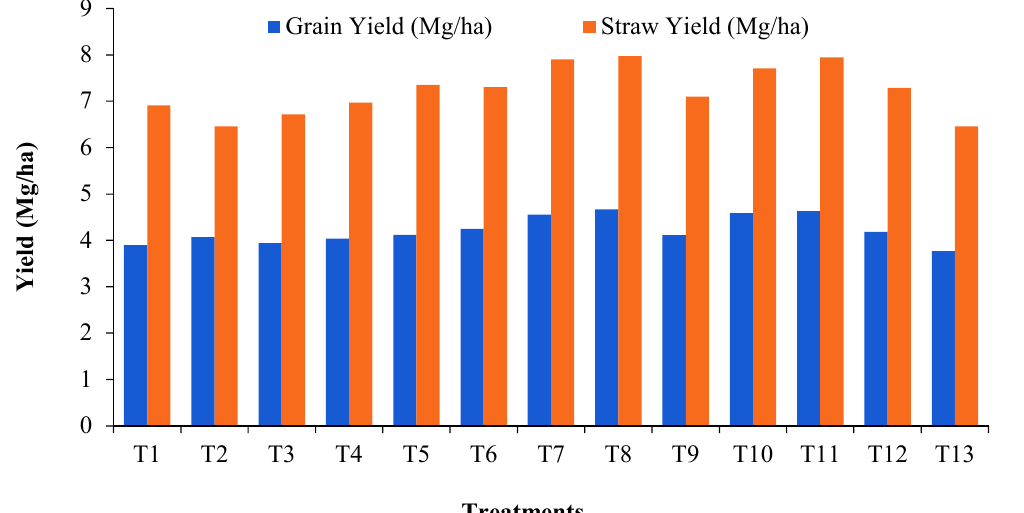
Figure 2. Effect of different treatments on yield of wheat. Treatments details are available in Table 2.